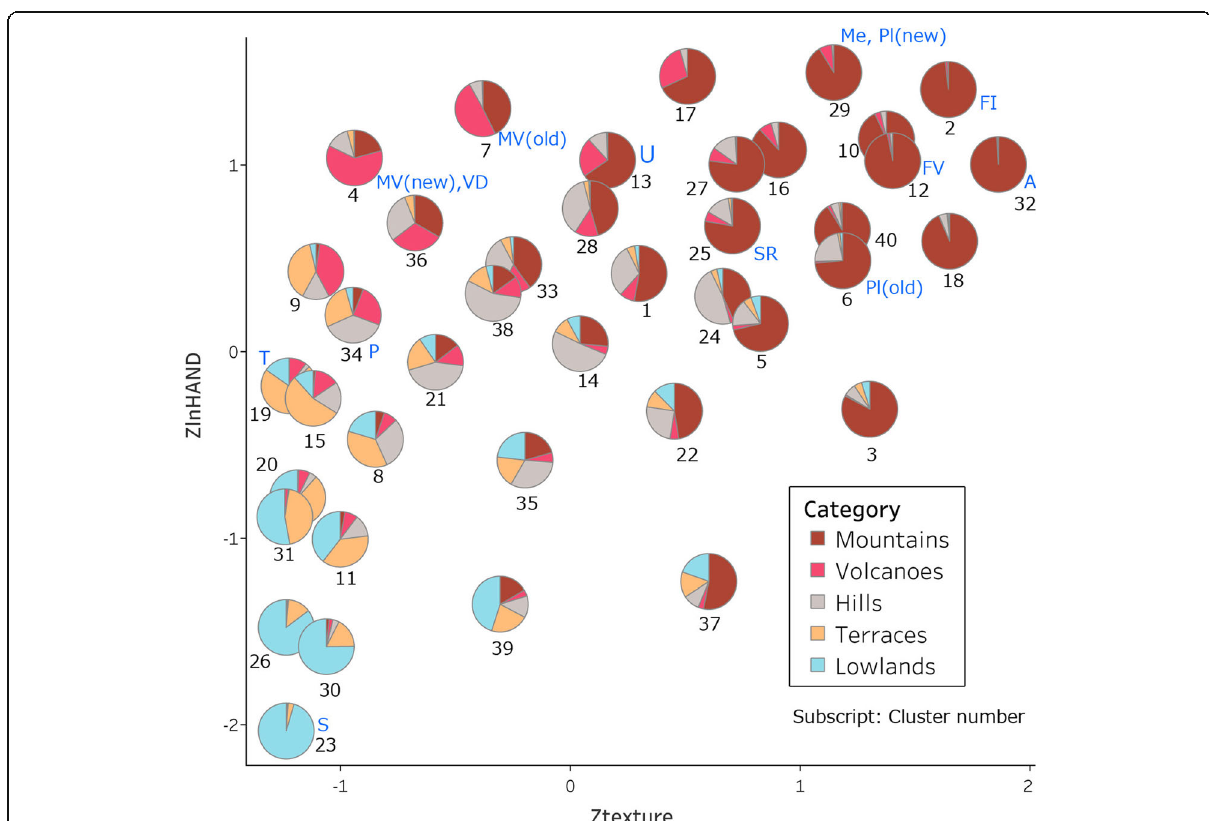
Fig. 9 Cross-tabulation of 40 clusters with geomorphological units showing breakdowns. The geomorphological units were aggregated from data 2. Black letters are the cluster numbers. Blue letters are the abbreviation of each legend in data 1 and are written next to the most frequent cluster. (S: Sedimentary rock or sediment (younger than Middle Miocene), SR: Sedimentary rock or sediment (older than Middle Miocene), Pl(new): Plutonic rock (younger than middle Miocene), Pl(old): Plutonic rock (older than middle Miocene), A: Accretionary complex, Me: Metamorphic rock, P: Pyroclastic flow deposits, MV(new): Mafic volcanic rock (Holocene), MV(old): Mafic volcanic rock (older), FV: Felsic volcanic rock, VD: Volcanic debris, T: Holocene tephra, U: Ultramafic rock, FI: Felsic intrusive